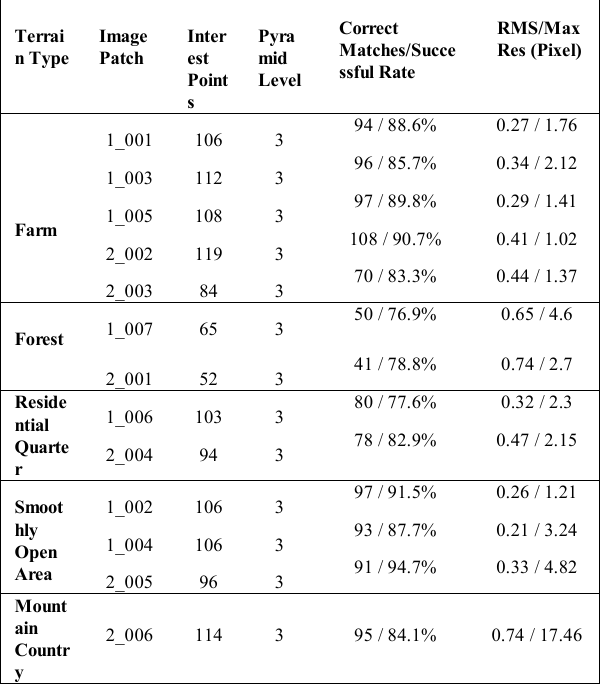
Table 3. Matching accuracy quantitative evaluation for different types of